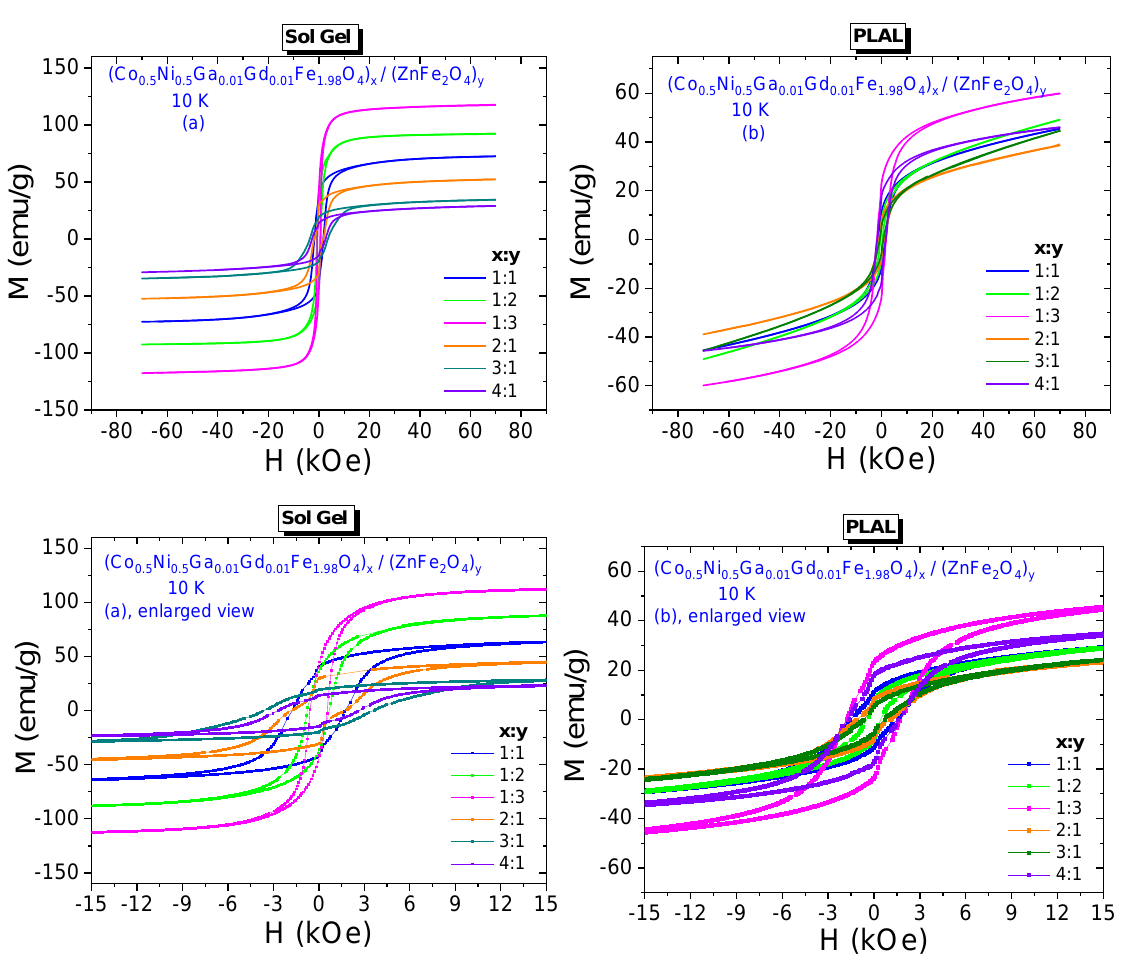
Figure 9. 10 K M-H curves recorded from (Co 0.5 Ni 0.5 Ga 0.01 Gd 0.01 Fe 1.98 O 4 ) x /(ZnFe 2 O 4 ) y NCs synthesized by ( a ) sol-gel method and enlarged view ( b ) laser ablation method and enlarged view.